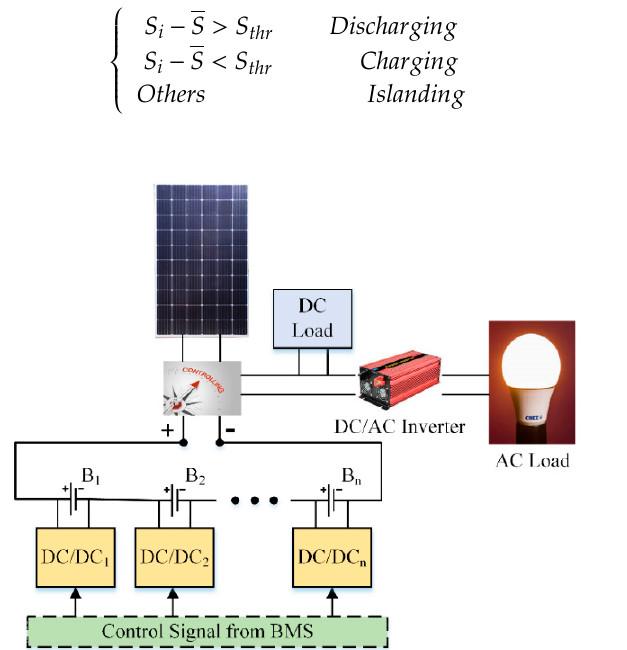
Figure 9. Active charge equalization structural design.